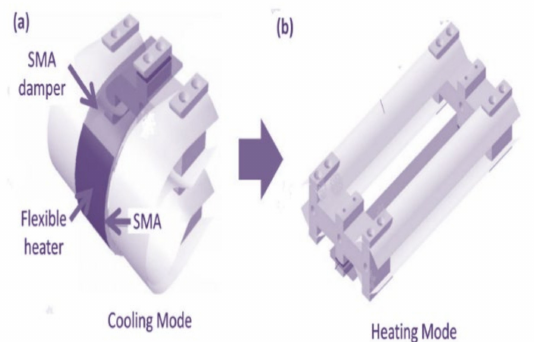
Figure 5. SMA damped tape spring hinge. ( a ) Stowed position; ( b ) Deployed position.